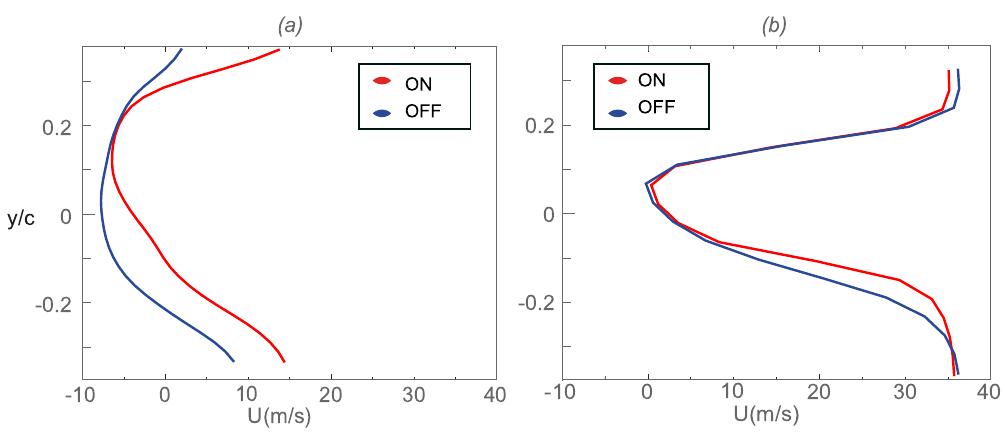
Figure 13. Cross-wake velocity profiles at T A for ( a ) α = 22 ◦ and U ∞ = 20 m/s and ( b ) α = 14.5 ◦ and U ∞ = 35 m/s.